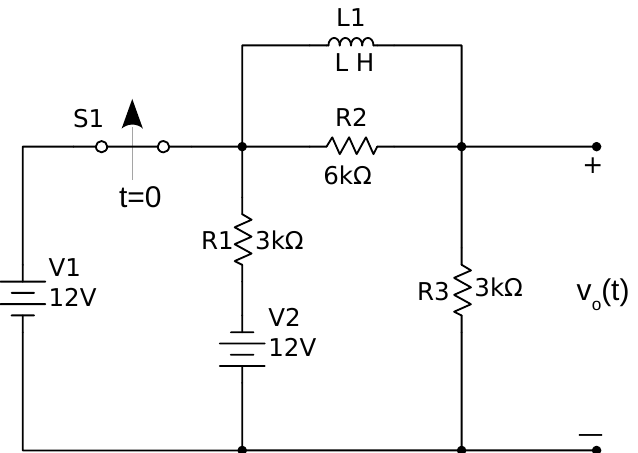
Figure 1. We investigate the response of the RL circuit after switch S1 is opened at t = 0. The exact value of the inductance of inductor L1 is not available and is known only to fall within a continuous